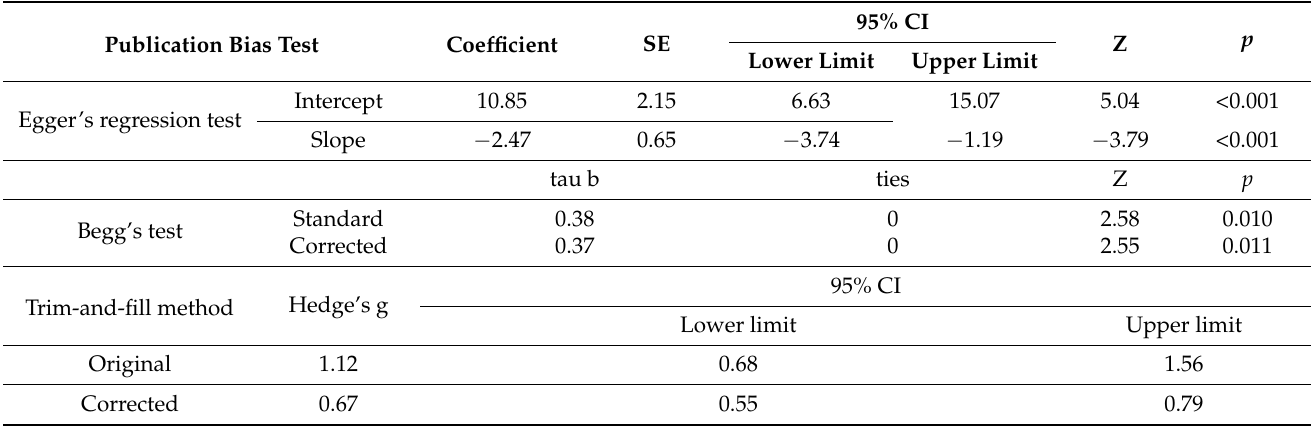
Table 8. Publication bias test of nurse support program on job satisfaction.